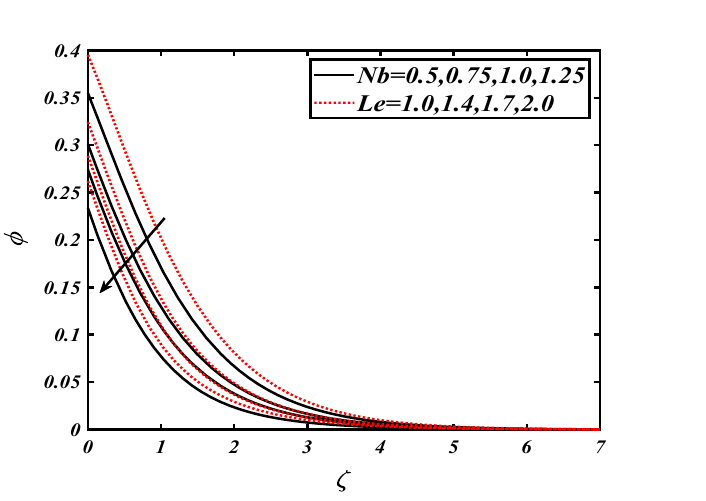
Figure 6. Illustration of (cid:31) and S over-temperature θ when Pr = 2.0, Rd = 0.4, γ 2 = 0.3, Nb = 0.2, Nt = 0.3, β = 0.2 .